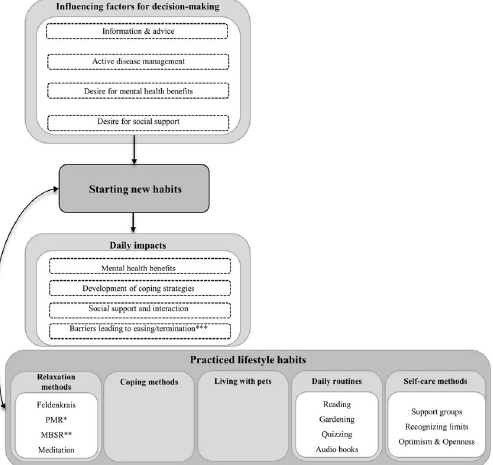
Fig 3. Sub-themes of stress management. � PMR = Progressive Muscle Relaxation according to Jacobson; �� MBSR = Mindfulness-Based Stress Reduction.